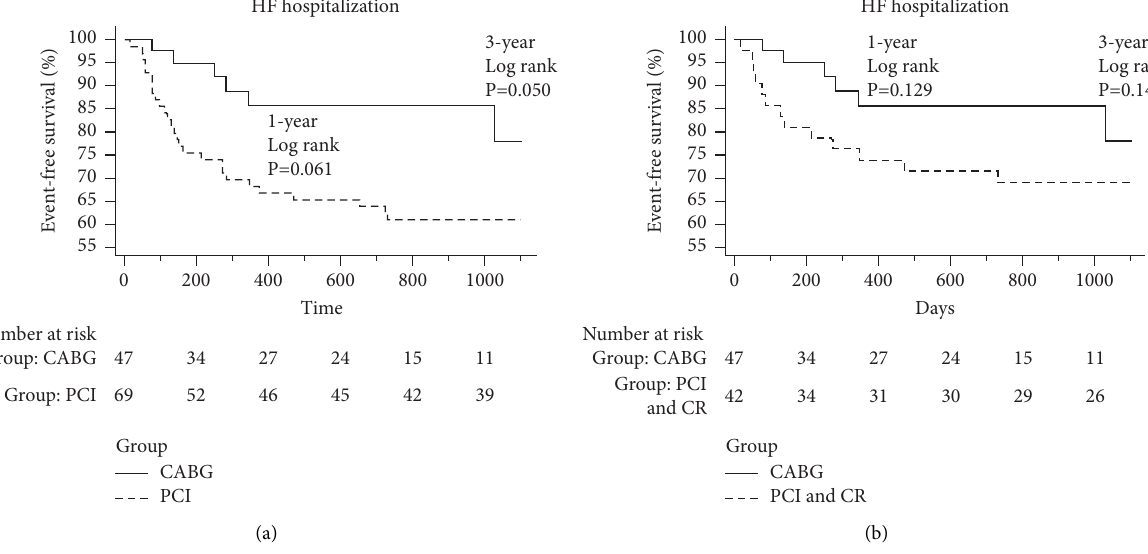
Figure 3: Kaplan–Meier curves of the 1- and 3-year HF hospitalization rates between the groups. (a) Te Kaplan–Meier curve of the 1- and 3-year HF hospitalization rates between CABG and all patients in the PCI group and (b) the Kaplan–Meier curve of the 1- and 3-year HF hospitalization rates between the CABG and the complete revascularization